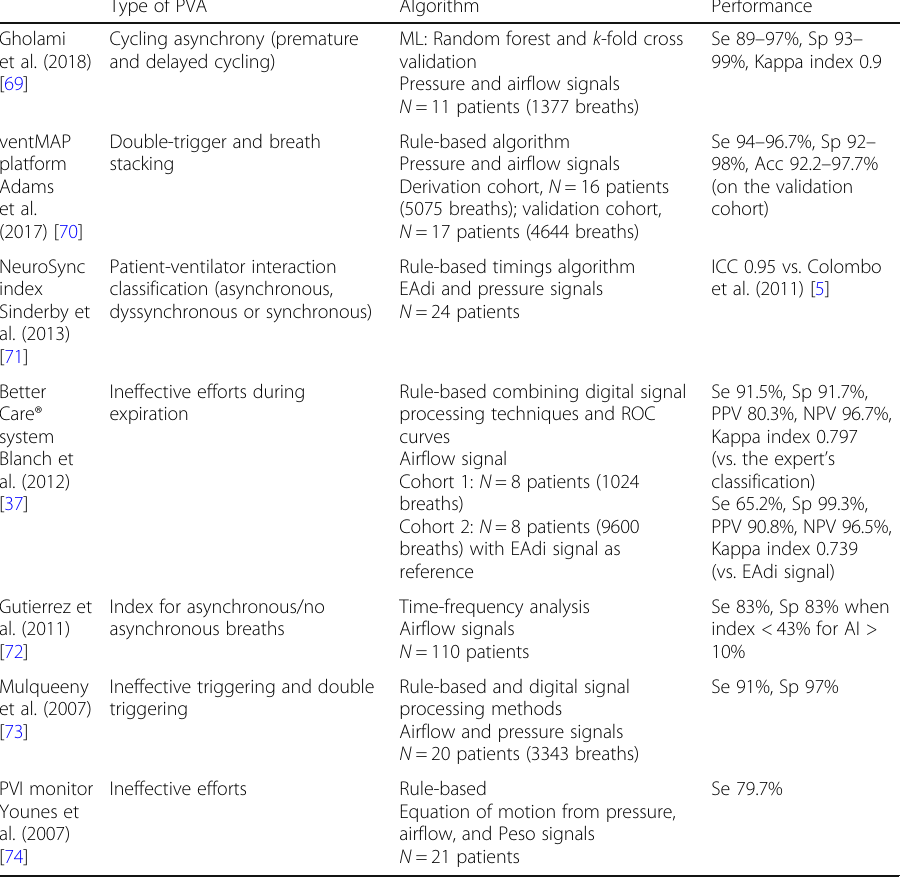
Table 1 Comparison of some automated methods for patient-ventilator asynchrony detection Type of PVA Algorithm